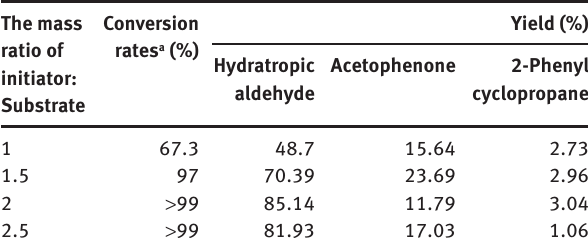
Table 4: The influence of aldehyde amount. The mass ratio of